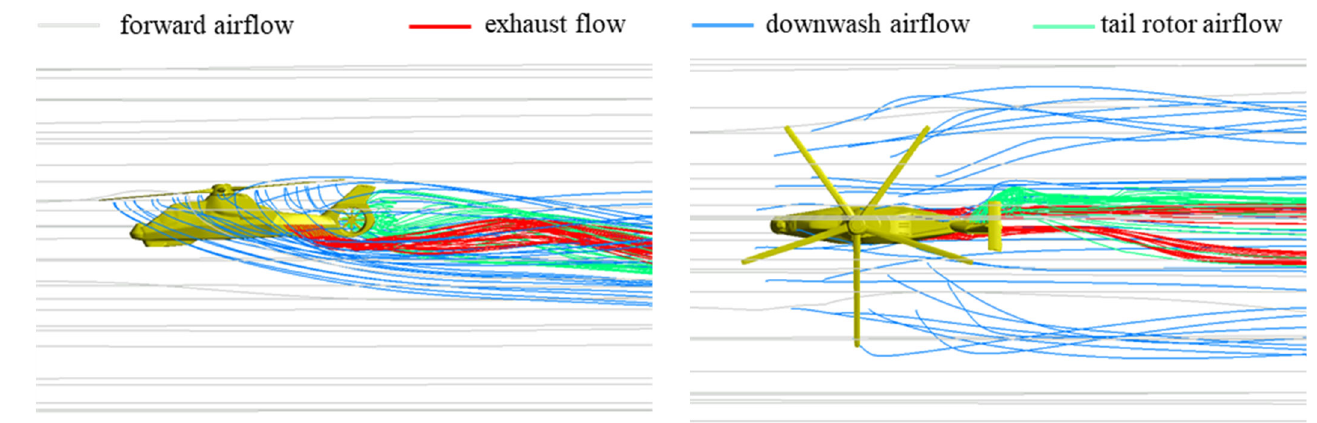
Figure 8. Streamlines of helicopter external airflow.